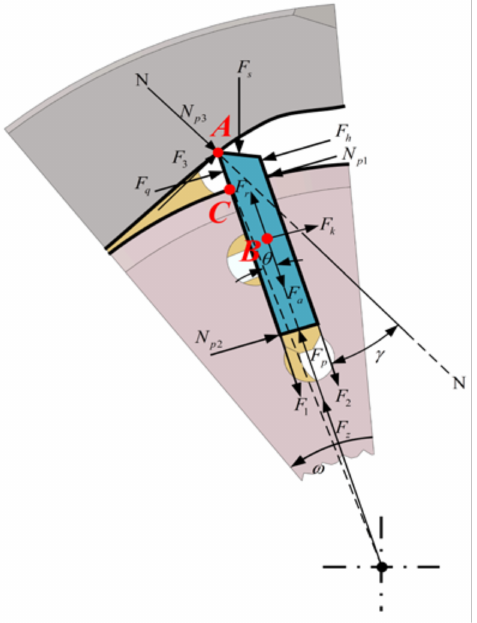
Figure 5. Force analysis of vanes in the oil discharge